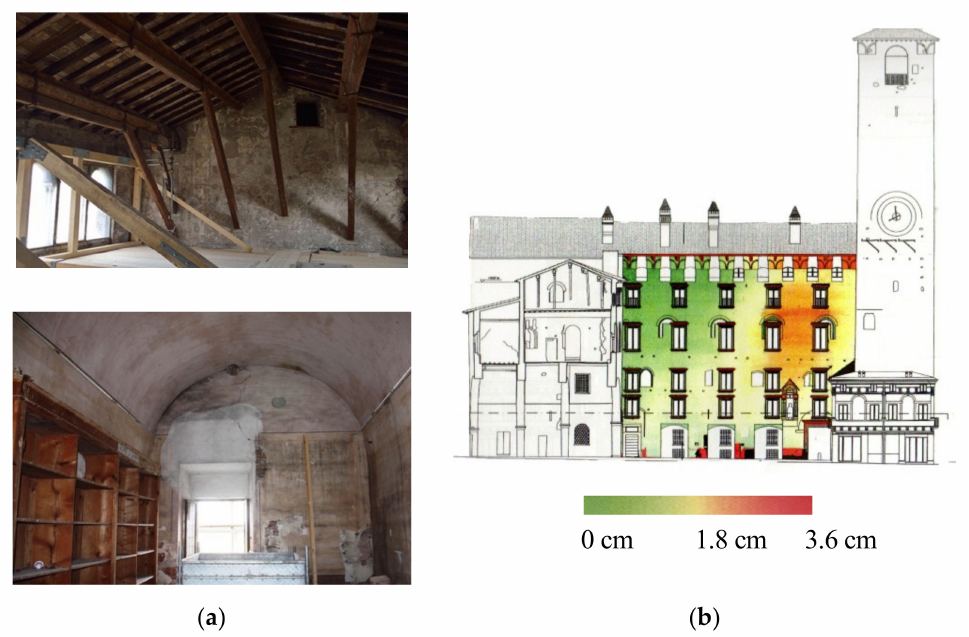
Figure 4. ( a ) Floors types (timber diaphragms and vaults); ( b ) out-of-plane deformations on the façade overlooking the Broletto square from laser scanner measurements made before and after the seismic